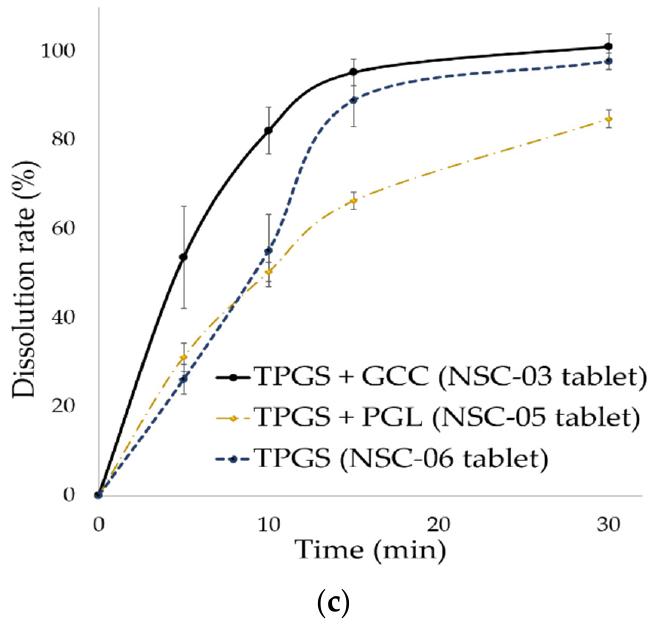
Figure 5. In vitro dissolution of NSC tablets. ( n = 3) ( a ) NSC tablet with lipids, NSC tablet without lipids, and physical mixture tablet; ( b ) NSC tablet by lipid and silica carrier composition ratio; and ( c ) NSC tablet by lipid component types. Abbreviations: L, lipid; C, carrier; L:C, lipid:carrier; NSC, nanoporous silica entrapped lipid-drug complex; TPGS, D- α tocopheryl polyethylene glycol 1000 succinate; GCC, glyceryl caprylate/caprate; PGL, propylene glycol monolaurate; DUT, dutasteride.